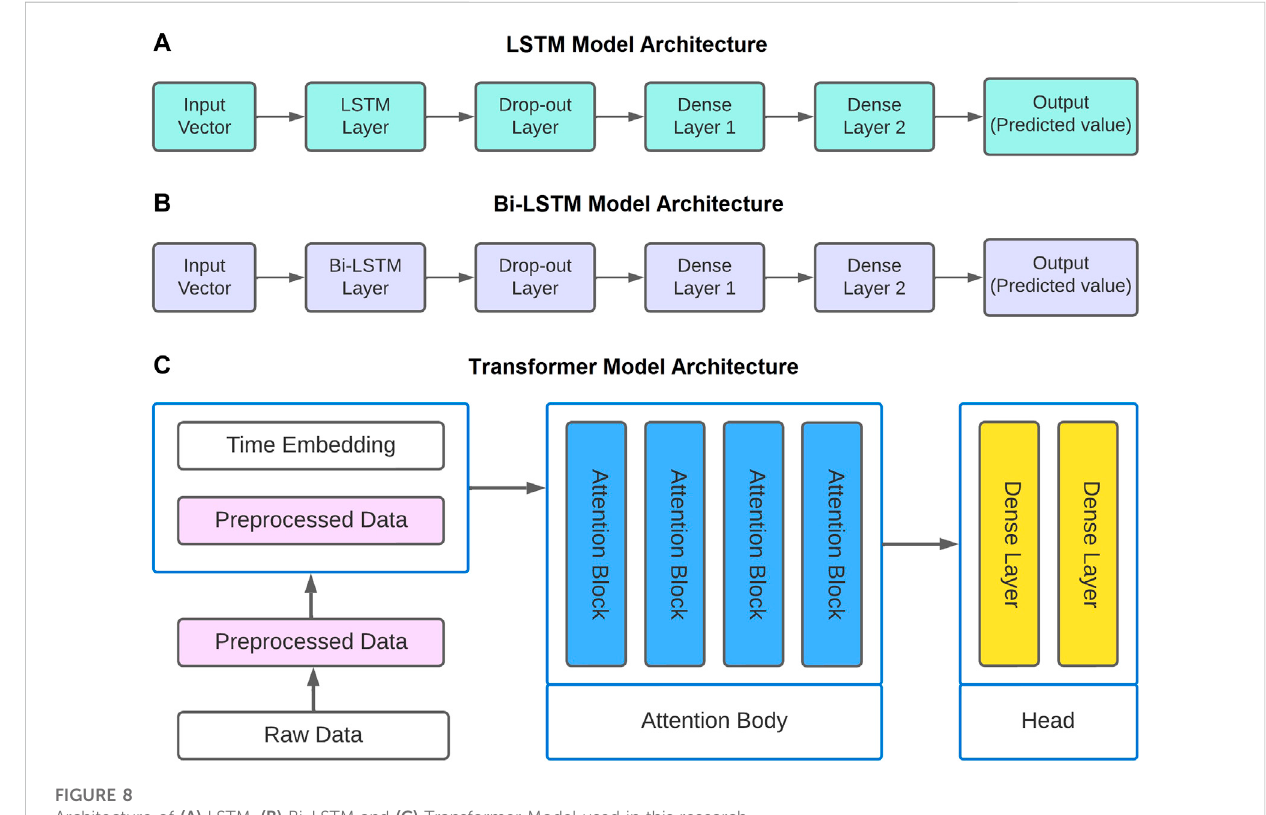
FIGURE 8 Architecture of (A) LSTM, (B) Bi-LSTM and (C) Transformer Model used in this